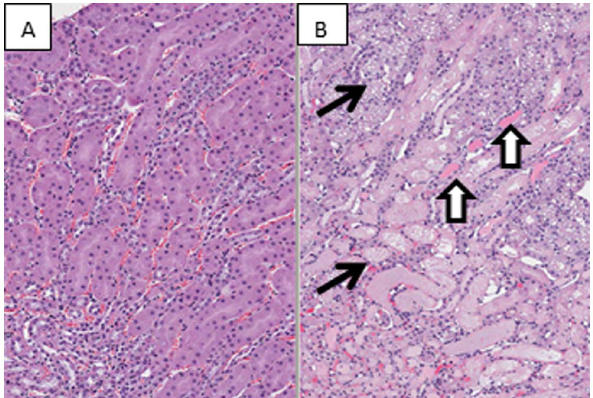
Figure 1. Histopathology of mouse kidneys associated with ischemia-reperfusion. A , sham operation. B , Twenty four hours after ischemia-reperfusion. Coagulative necrosis of the proximal tubule (arrows). Neutrophils have been recruited to the interstitium adjacent to areas of necrosis. Protein casts are scattered throughout the section (block arrows). Hematoxylin and Eosin, 100 6 magnification.